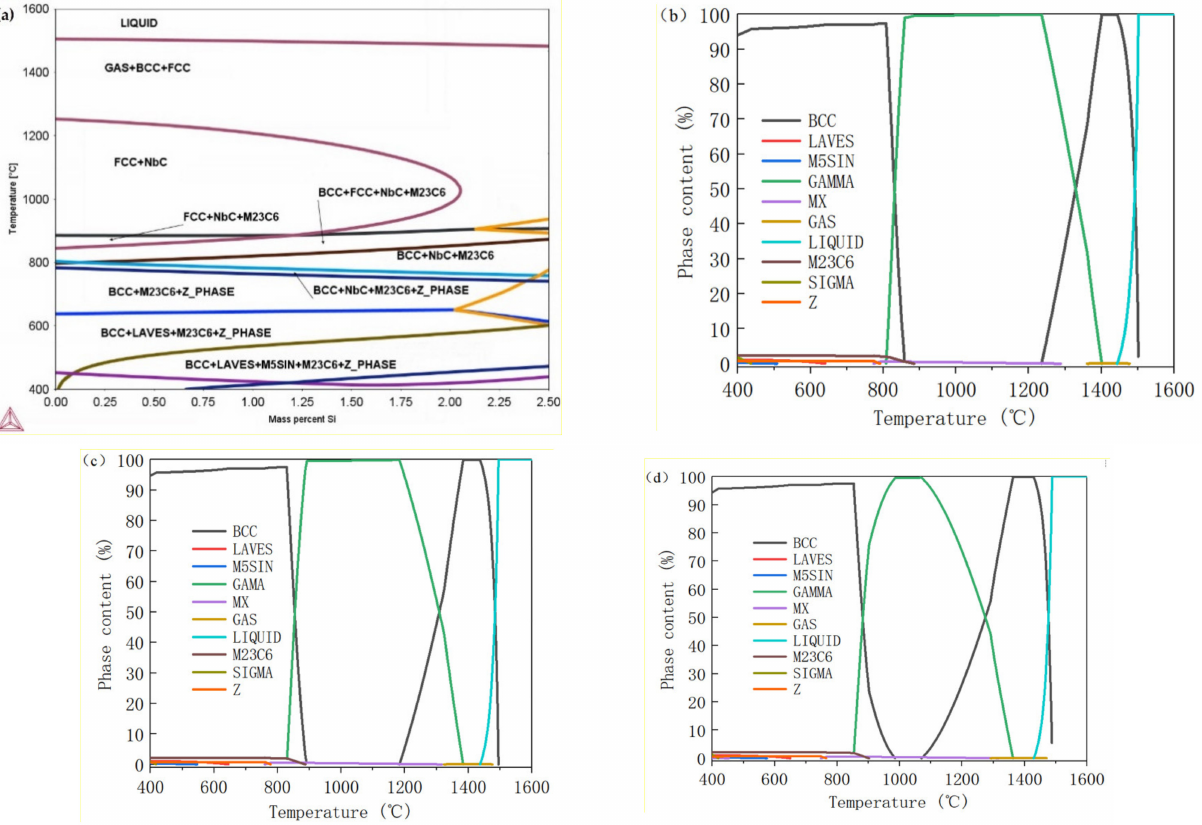
Figure 2. Thermal-Cal results. ( a ) Equilibrium phase diagram. ( b – d ) Precipitate change of T91LSi, T91MSi, and T91HSi with